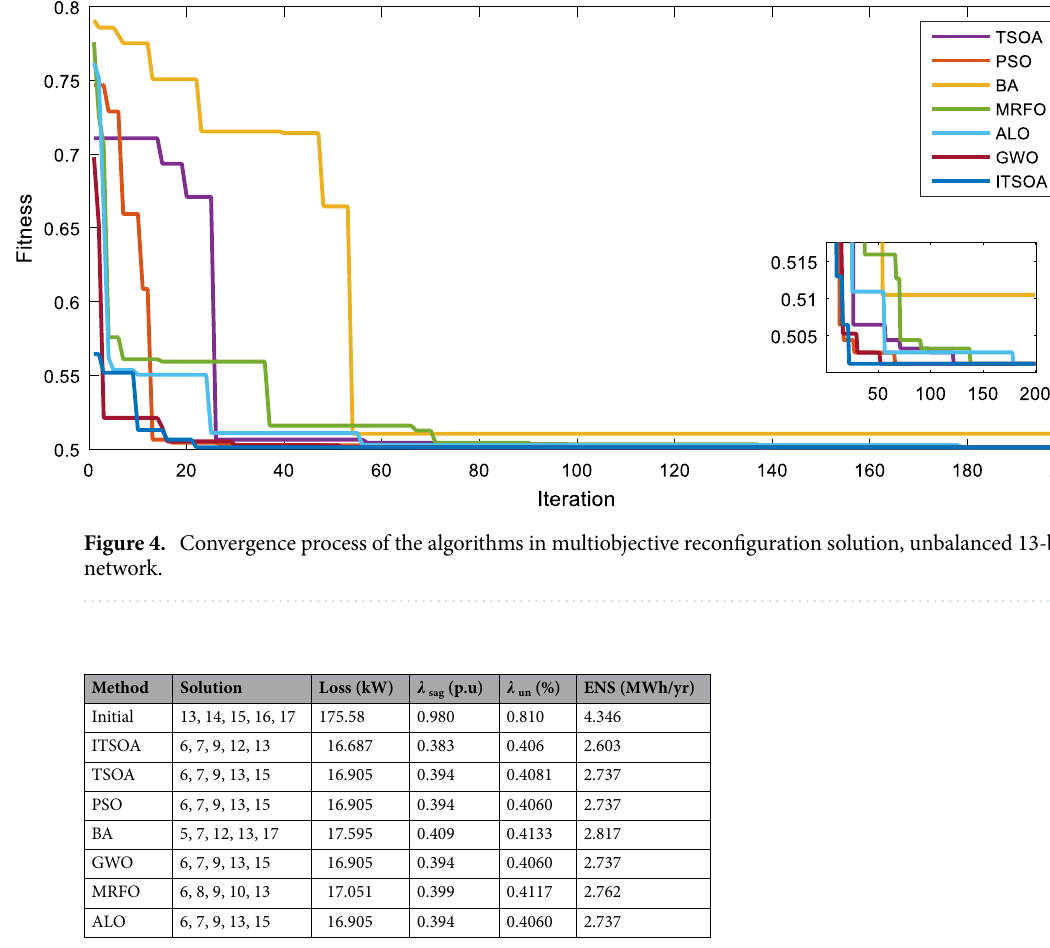
Table 5. Simulation results of multiobjective reconfiguration unbalanced 13-bus